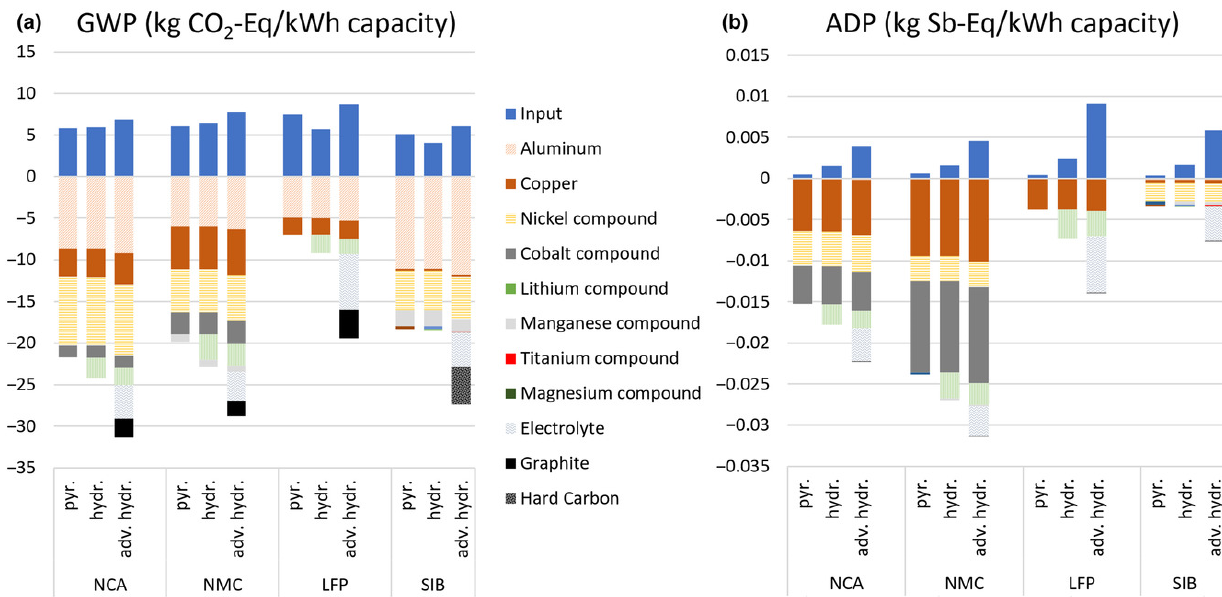
Figure 7. Environmental benefits of battery cell recycling, broken down to the contribution of the different fractions recovered by the recycling processes: ( a ) global warming potential (GWP), ( b ) abiotic resource depletion potential (ADP). Negative values indicate net benefits (reduction of impacts due to recovered materials), positive values are environmental impacts (due to process inputs and emissions, e.g., energy and chemicals, off-gasses). Reprinted from Journal of Industrial Ecology, Vol. 24, Mohr et al. [161], Toward a cell-chemistry specific life cycle assessment of lithium-ion battery recycling processes, no. 6, pp. 1310–1322, Copyright (2022), distributed under Creative Commons Attribution License.